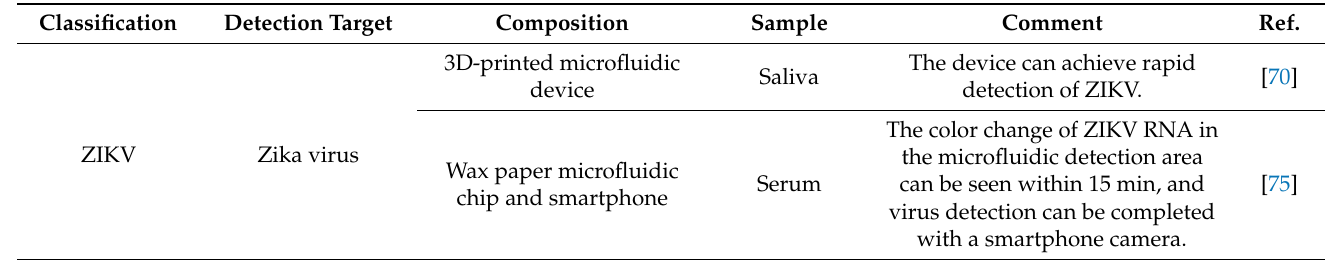
Table 3. The overview of applications of Microfluidic POC devices in early diagnosis of infectious